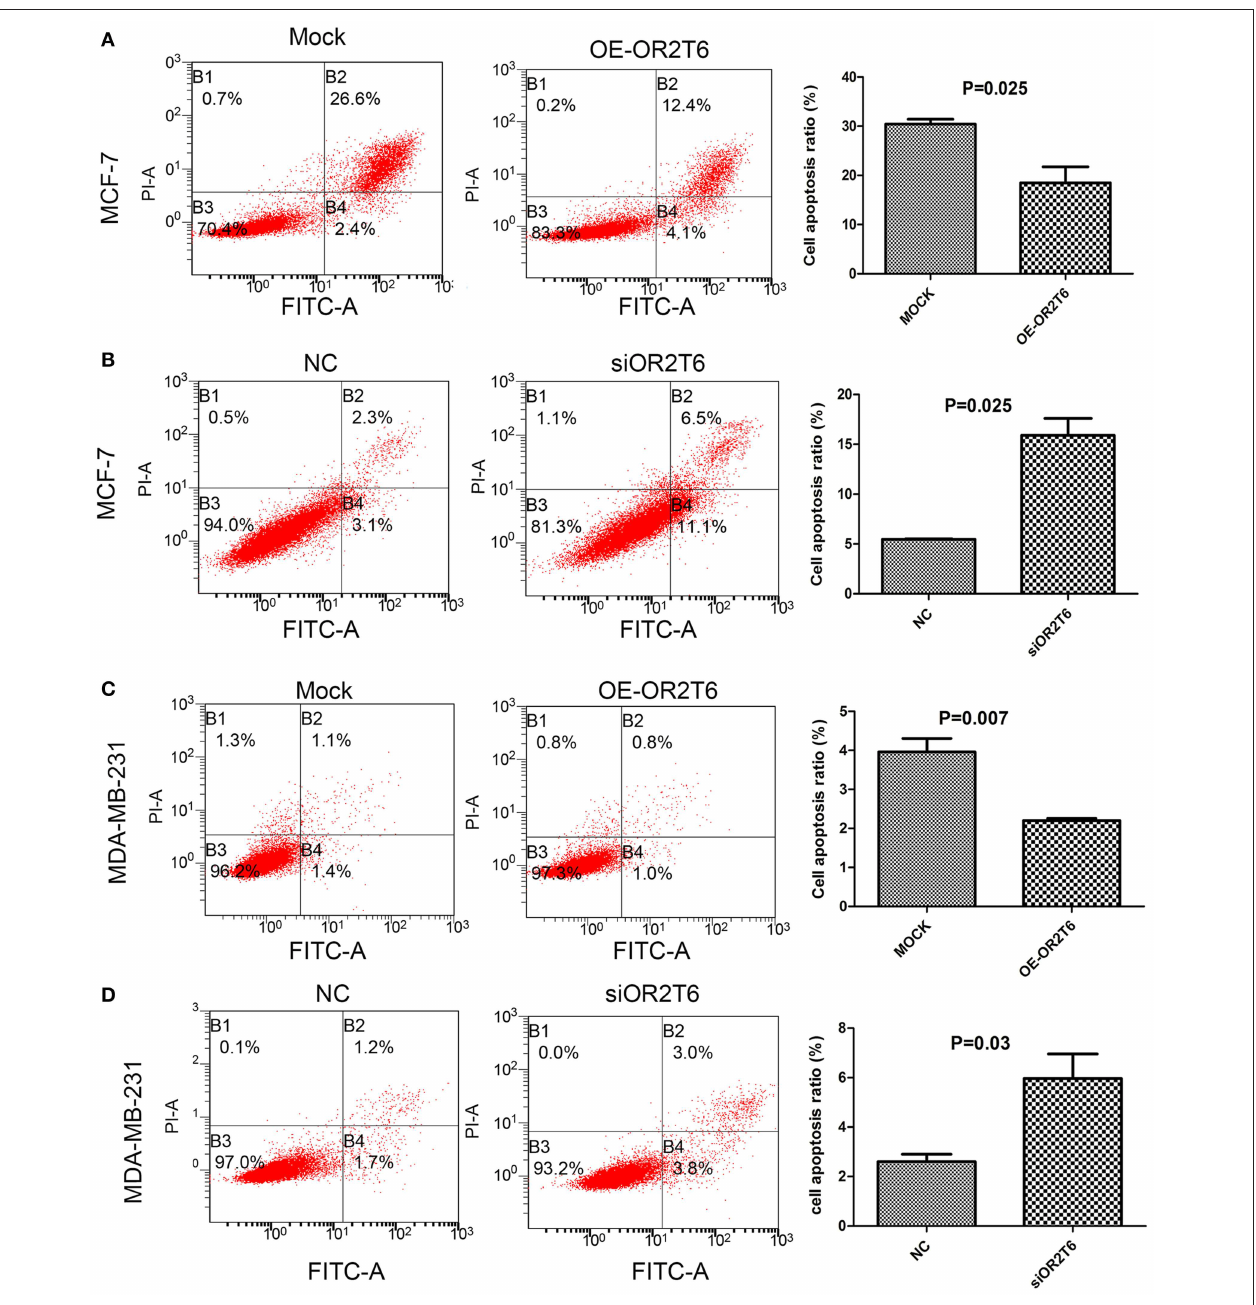
FIGURE 3 | OR2T6 inhibited apoptosis of breast cancer cell lines. Cells were collected at 72h after transfection, stained with Annexin V-FITC and PI and then analyzed by flow cytometry. Apoptosis of MCF-7 and MDA-MB-231 cells was inhibited by overexpression of OR2T6 (A,C) and enhanced by interference with OR2T6 expression (B,D) . Student’s t -test was implemented to compare the difference between the two groups. Results were representative of triplicate experiments.